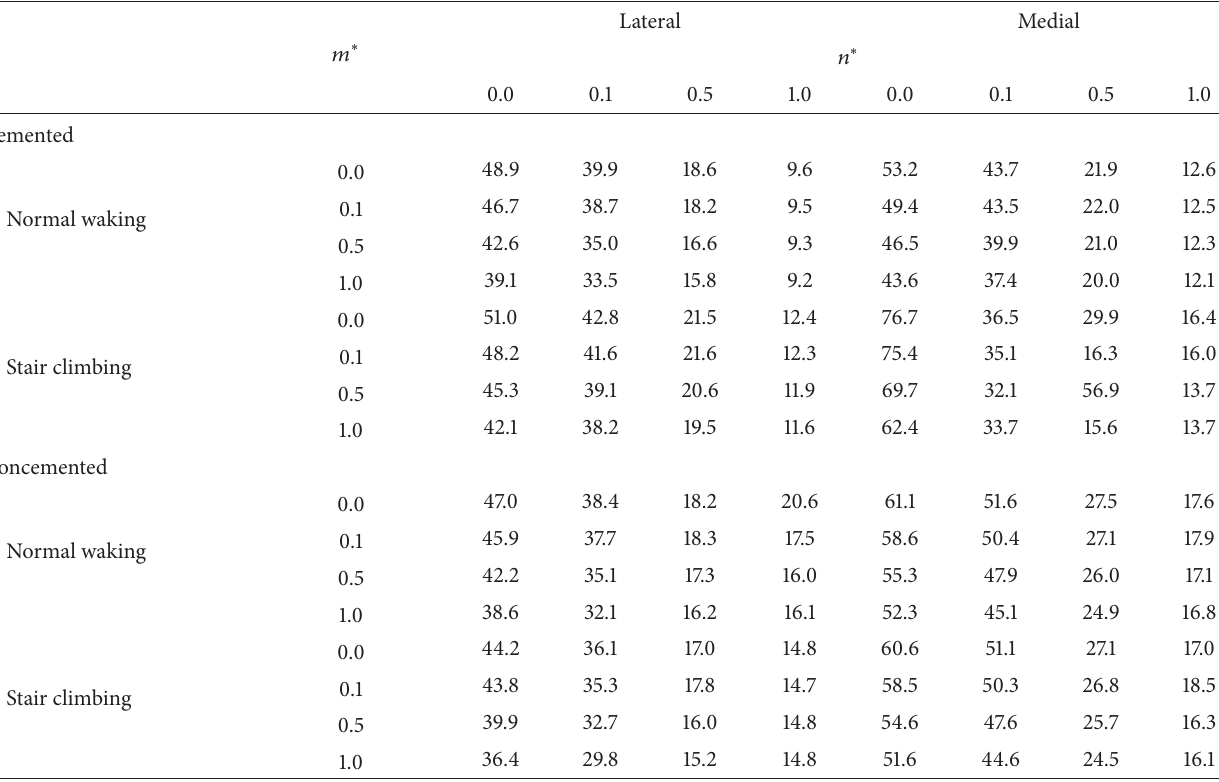
∗ 𝑛 : radial volume fraction gradient exponent. ∗ 𝑚